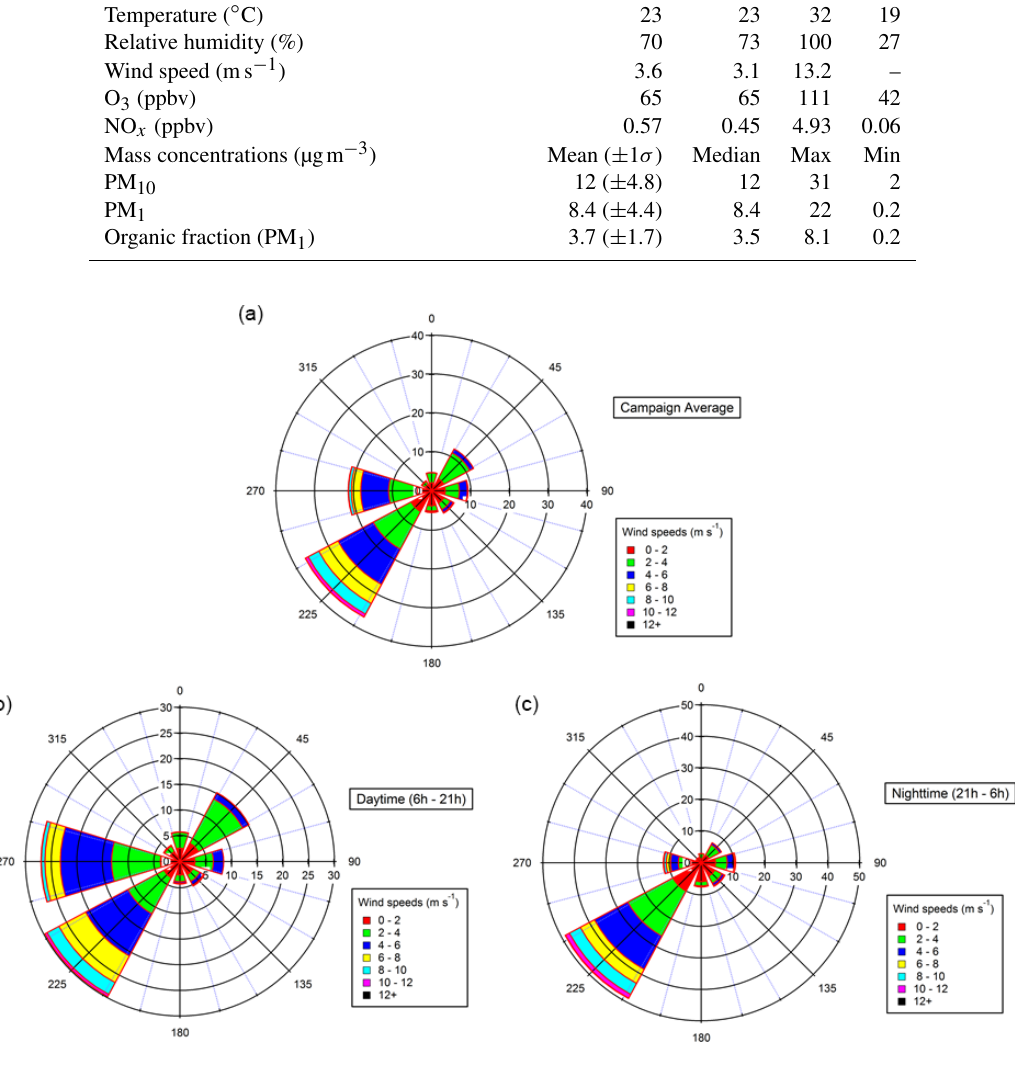
Figure 1. Wind roses from 15 July to 5 August 2013 (a) during daytime only (b) and during nighttime only (c) . Wind direction is expressed in degrees, and radial axes express the relative occurrence of wind in each 30 ◦ sector